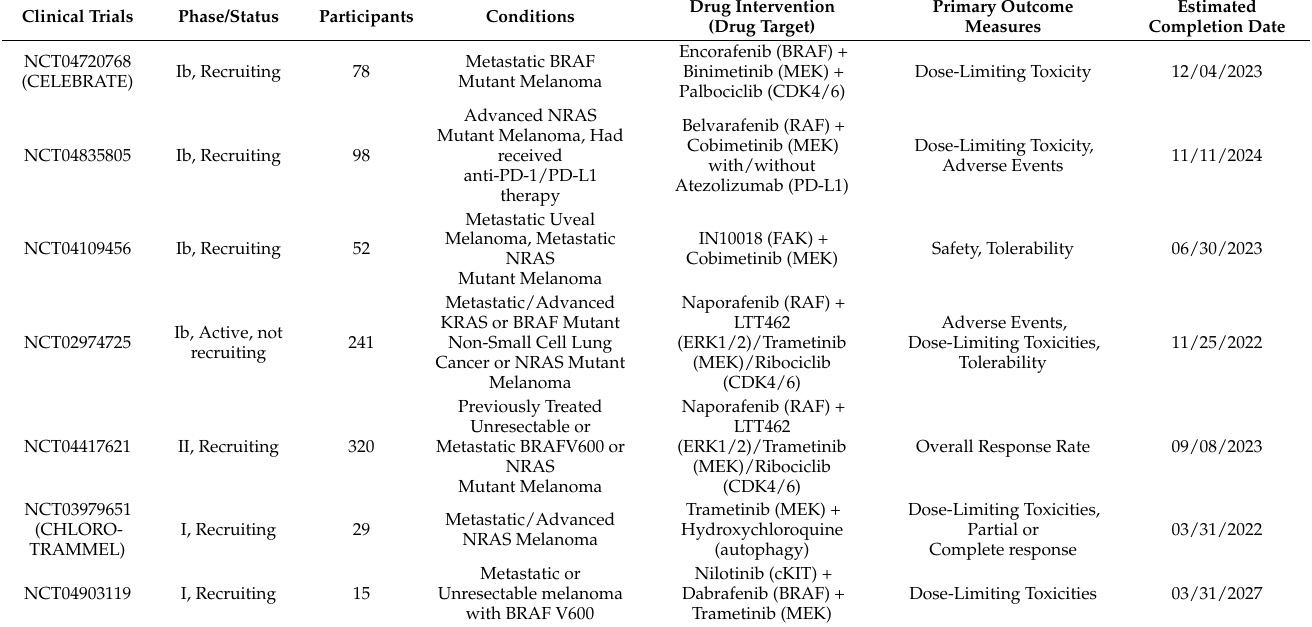
Table 2. Current combination therapy clinical trials for advanced/metastatic